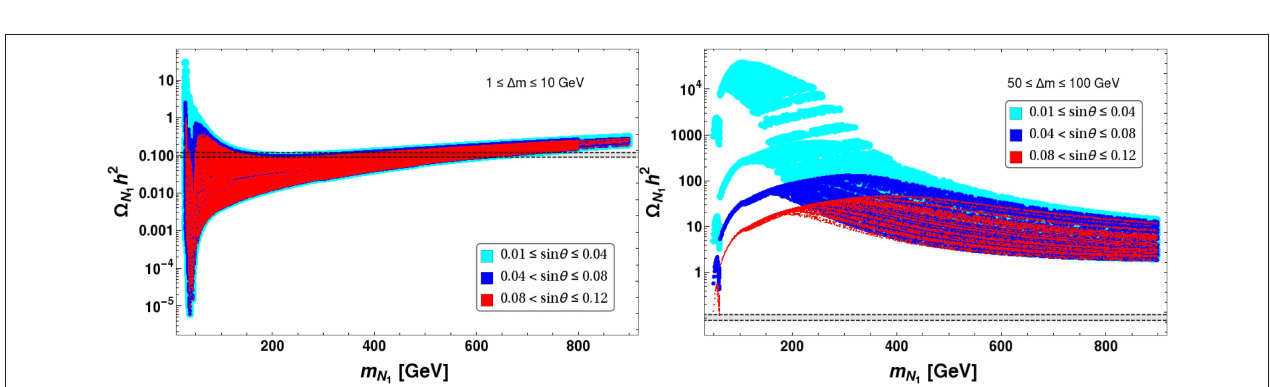
100 (Gray). Correct relic density, 0.1166 ≤